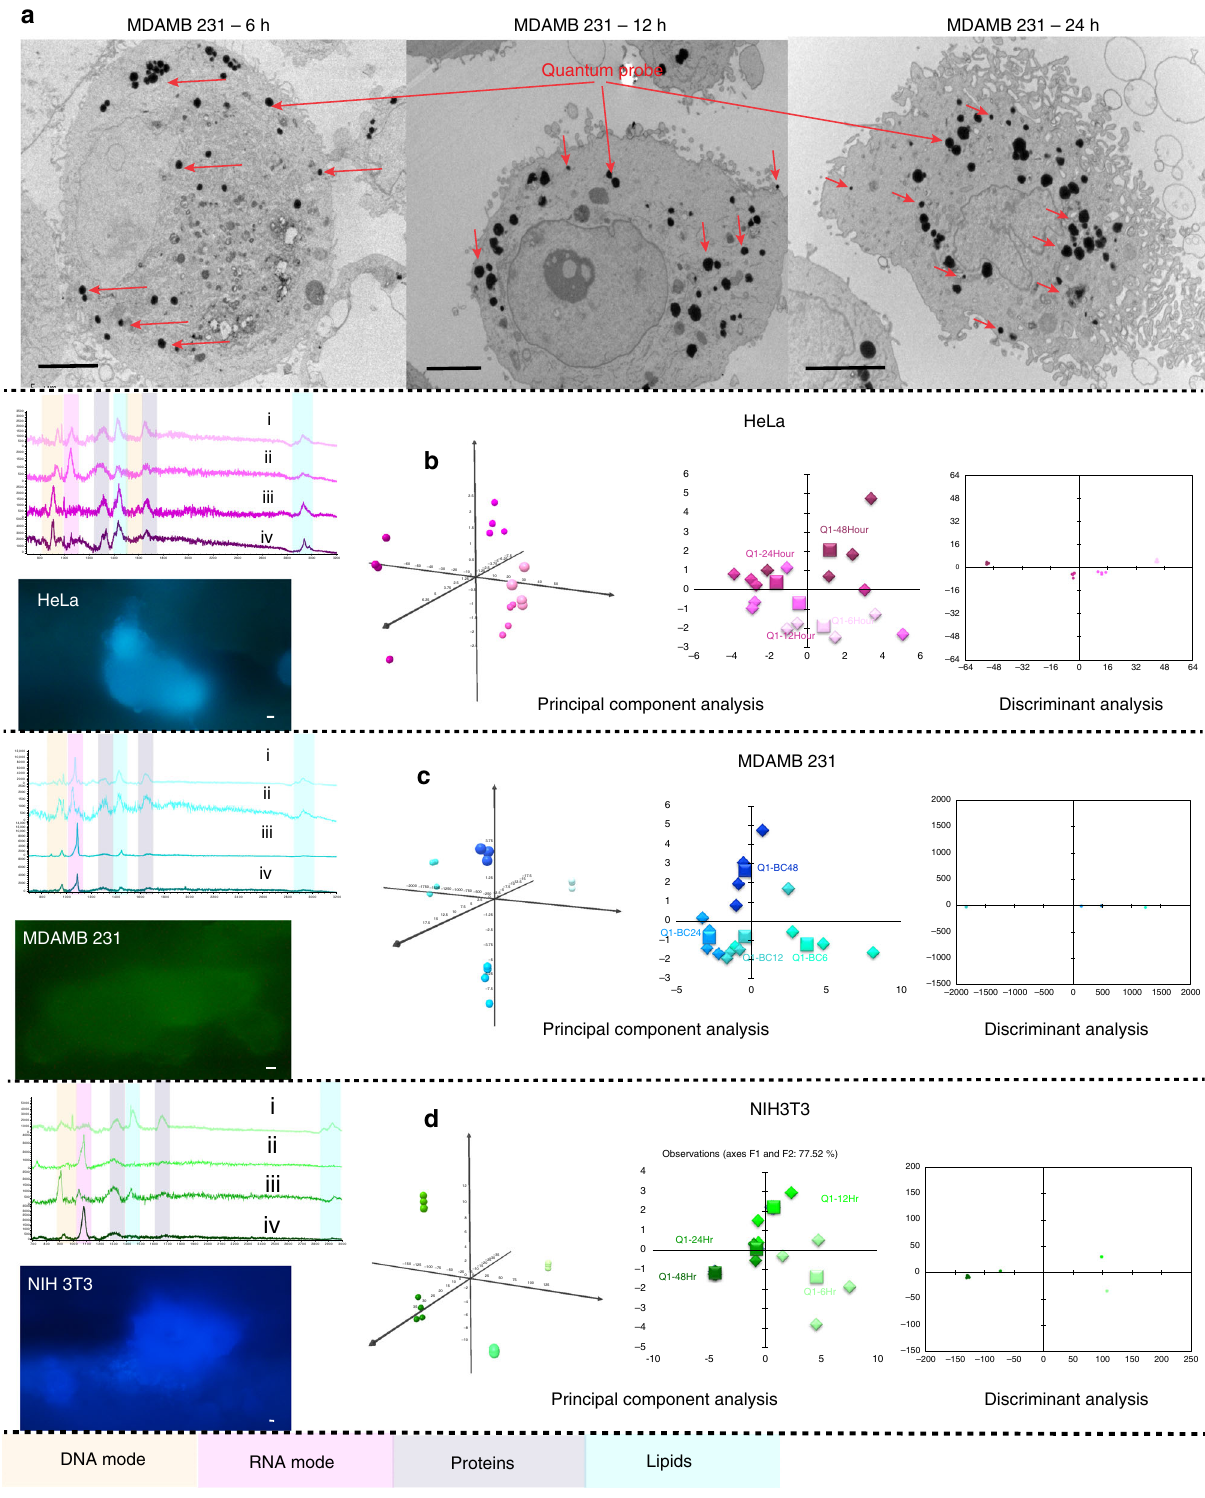
Fig. 8 Time-based study of cancer and non-cancer cells using multivariate analysis. a TEM images of cells showing cellular uptake and internalization of the quantum probe. Internalization was time dependent. Scale bar = 5 µ m. Scale bar for fl uorescence images 20 µ m. 6 h (i), 12 h (ii), 24 h (iii), and 48 h (iv) SERS spectra in b , c , d . The “ x ” axis of the spectra display Raman shift (cm − 1 ) and “ y ” axis displays arbitrary units. Time-dependent PCA and DA of HeLa ( b ), MDAMB231 ( c ), and NIH3T3 ( d ). PCA displays 3D plot of principal components F1 on “ x ” axis F2 on “ y ” axis and F3 on “ z ” axis as well as 2D plot of F1 on “ x ” axis and F2 on “ y ” axis. Clear clustering and separation of centroids is evident. DA displays discriminant components F1 on “ x ” axis and F2 on “ y ” axis. Various biomolecular modes show sinusoidal enhancement trends at 12h and 24 h. The intensity increased at 48 h. This may be due to the increase in the quantity of the probe within the